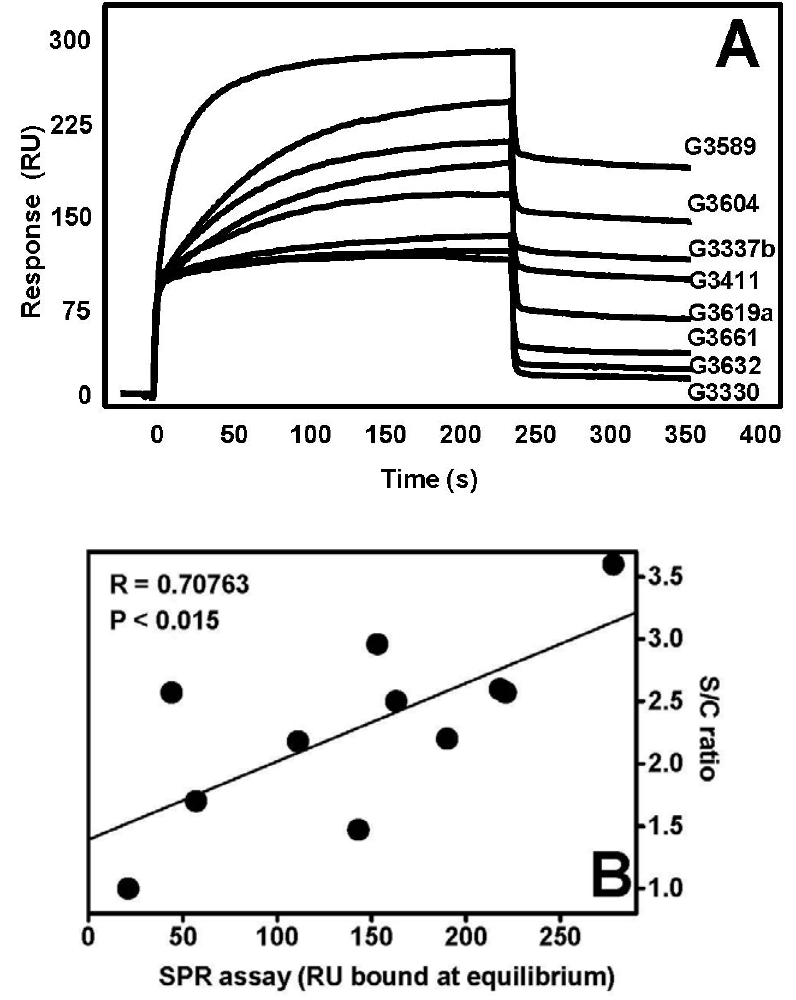
Figure 6. SPR runs of FGF2/K5 derivative interaction. FGF2 was immobilized to a sensorchip as described in [133]. Immobilized BSA was used as control and for blank subtraction. The various K5 derivatives (30 nM) were injected onto the FGF2- or BSA- coated sensor chips for four minutes and washed until full dissociation. After each run, the sensor chips were regenerated by a 2 M NaCl pulse [133]. A) Blank-subtracted sensorgram overlay showing the binding of K5 derivatives to sensorchip-immobilized FGF2. B) Plot of the blank-subtracted values of the SPR response at equilibrium for equimolar concentrations of each K5 derivative versus its sulfate/carboxyl (S/C) ratio. The SPR responses at equilibrium are taken from a single experiment out of three giving consistent